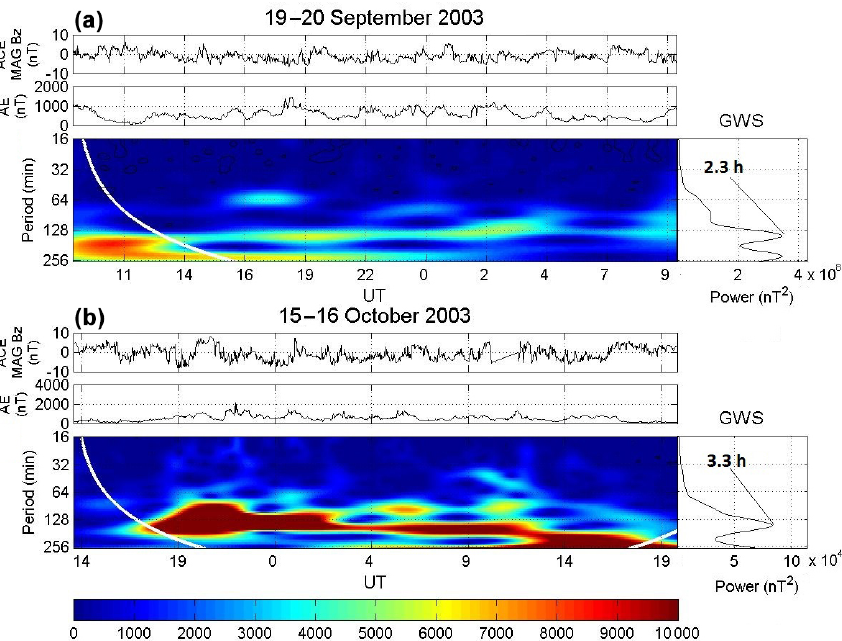
Figure 5. Cross-wavelet spectra between ACE IMF B z component data and AE index for the (a) 19–20 September 2003 tail crossing (T2) and for the (b) 15–16 October 2003 tail crossing (T5). Otherwise the format is the same as for Fig.